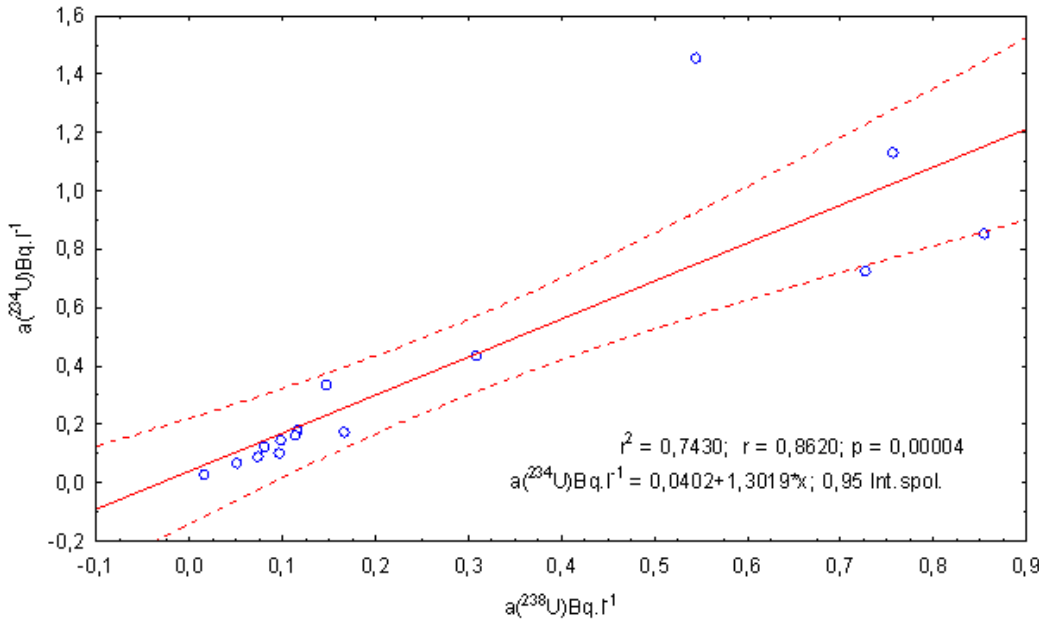
FIGURE 3. A correlation graph of 234 U volume activity vs. 238 U for the mine water samples collected in the areas Novoveska Huta of East Slovakia.